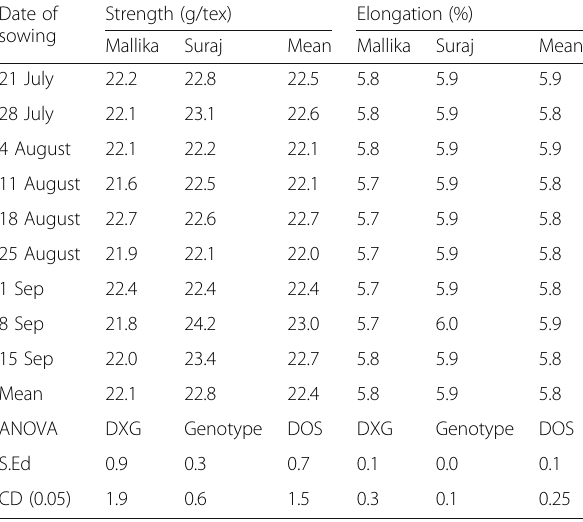
Table 7 Quality parameters as influenced by genotypes and dates of sowing Date of